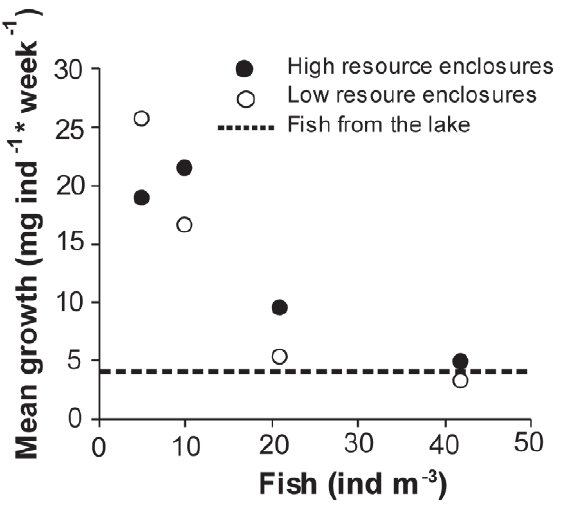
Figure 5. Growth rates of fish in high and low resource enclosures along a fish density gradient (means over time ± SE).